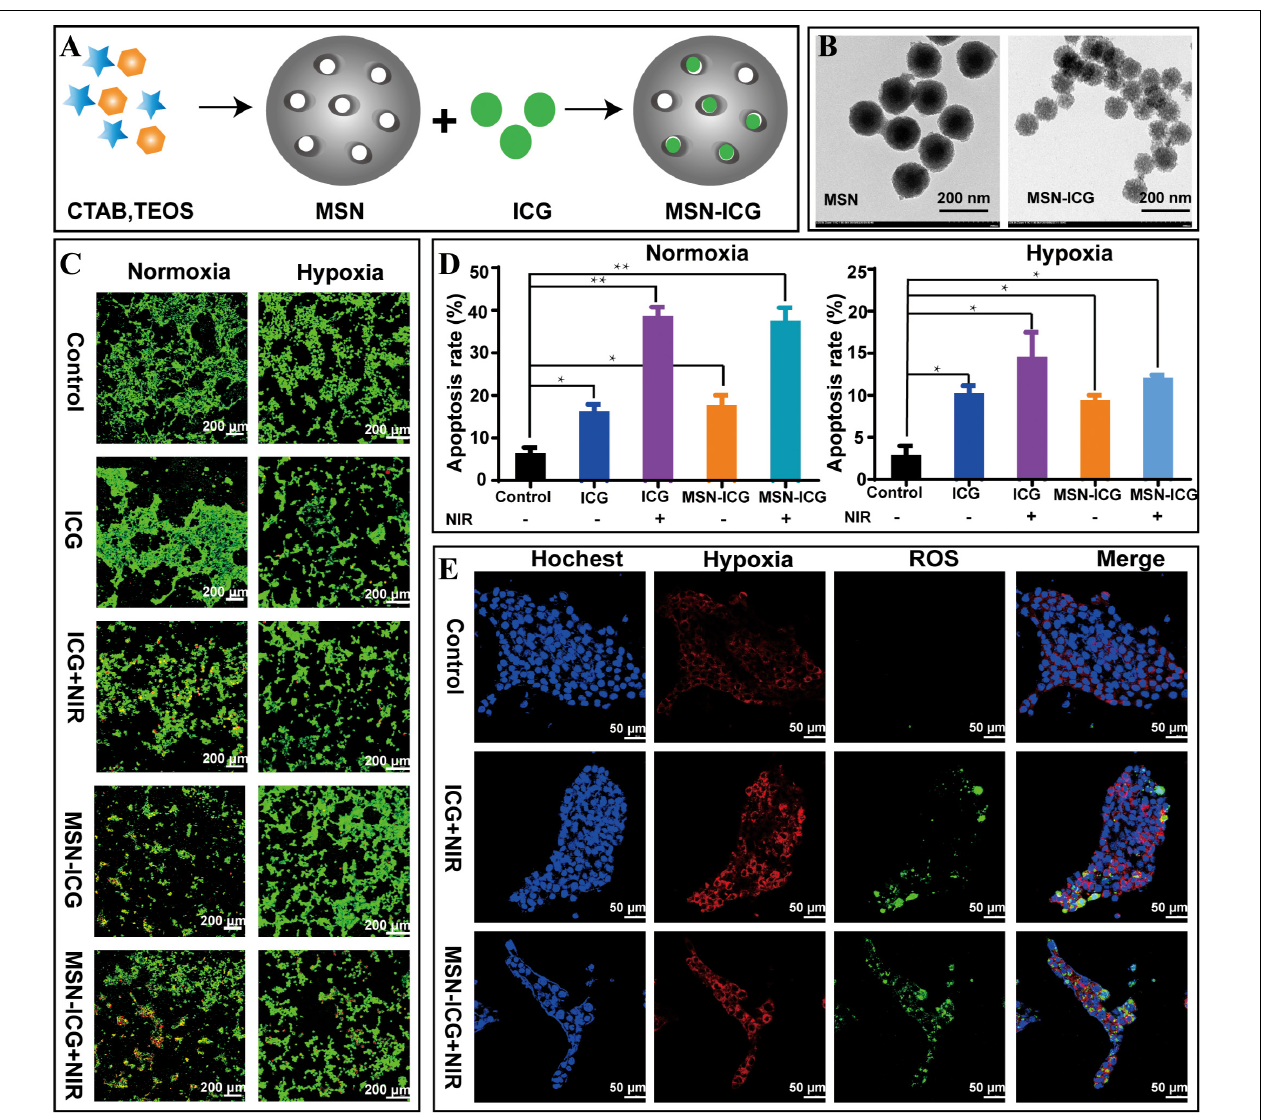
FIGURE 2 | The preparation and characterization of MSN-ICG. (A) The preparation process of MSN-ICG. (B) TEM images of MSN before and after ICG loading. (C,D) Live/dead staining and cell apoptosis analysis of 4T1 cells treated with control, ICG or MSN-ICG with or without 808 nm laser irradiation under normoxic or hypoxic condition. (E) Measurements of hypoxia and ROS for 4T1 cells treated with control, ICG or MSN-ICG with 808 nm laser irradiation under normoxia. * p < 0.05, ** p < 0.01 compared with control group by Student’s t -test. MSN-ICG, indocyanine green-loaded mesoporous silica